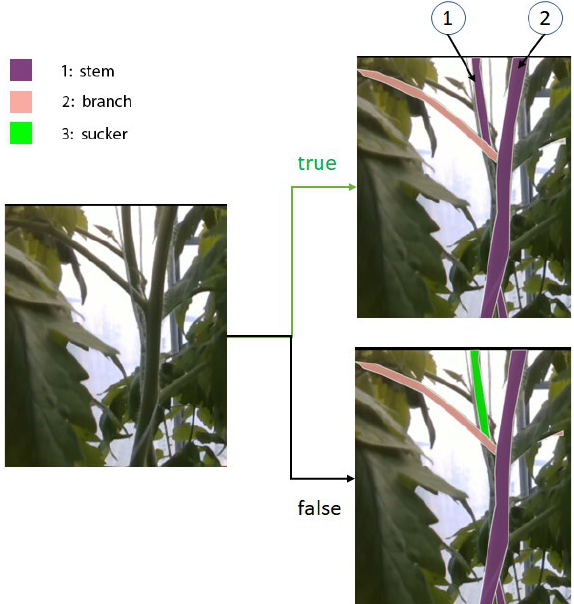
Figure 2. An example of a misunderstanding. The stem (1) can be recognized as a sucker because its position is between a branch and the stem (2) in the RGB image.